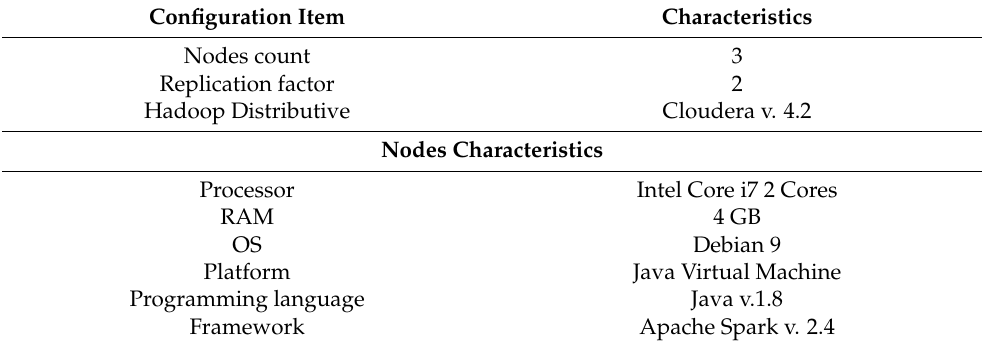
Table 1. Experimental stand configuration.